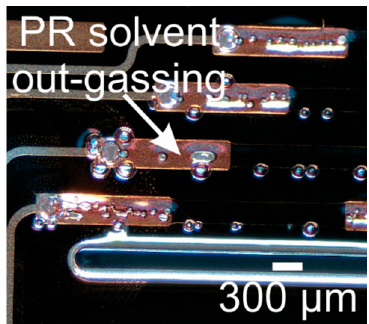
Figure 17. Out-gassing of photoresist solvent results in bubbling observed in sacrificial photoresist structures sandwiched in Parylene following O 2 deep reactive ion etching (DRIE).